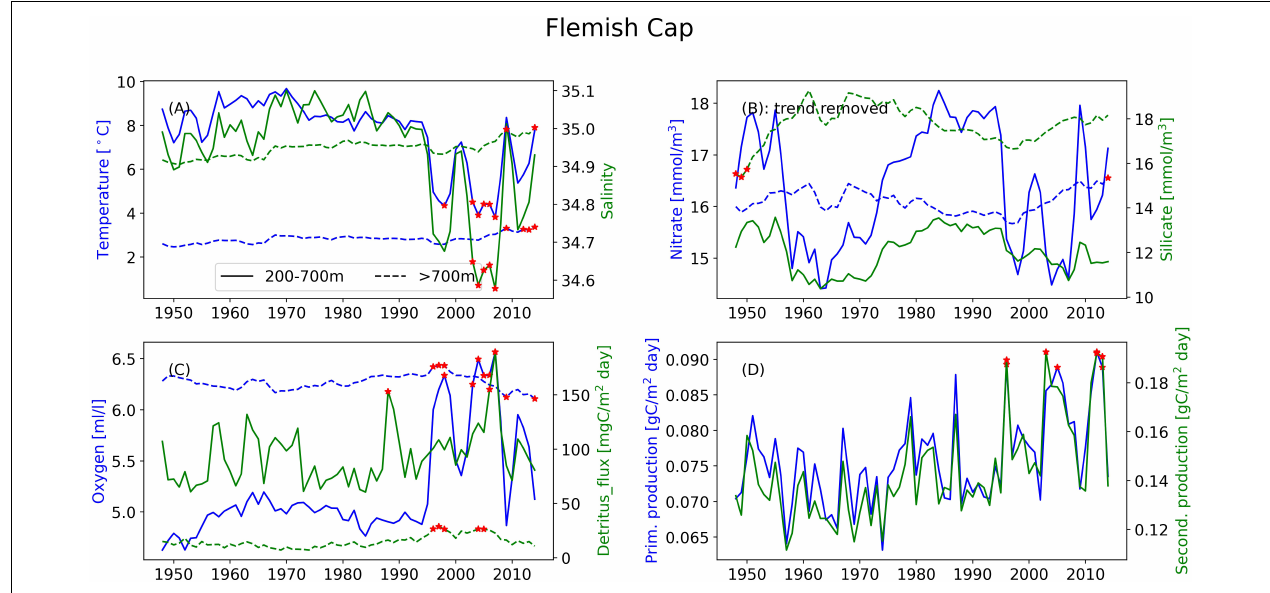
FIGURE 4 | Timeseries of the annual mean of different variables illustrating the interannual variability at the Flemish Cap for (A) temperature (blue) and salinity (green), (B) nitrate (blue) and silicate (green), and (C) oxygen (blue) and detritus (green). Solid lines are areas with bottom depth between 200 and 700 m, dashed lines are areas deeper than 700 m. (D) Depth-integrated primary production (blue) and secondary production (green) from the full area. Red stars indicate years when values are outside two standard deviations of the temporal mean.